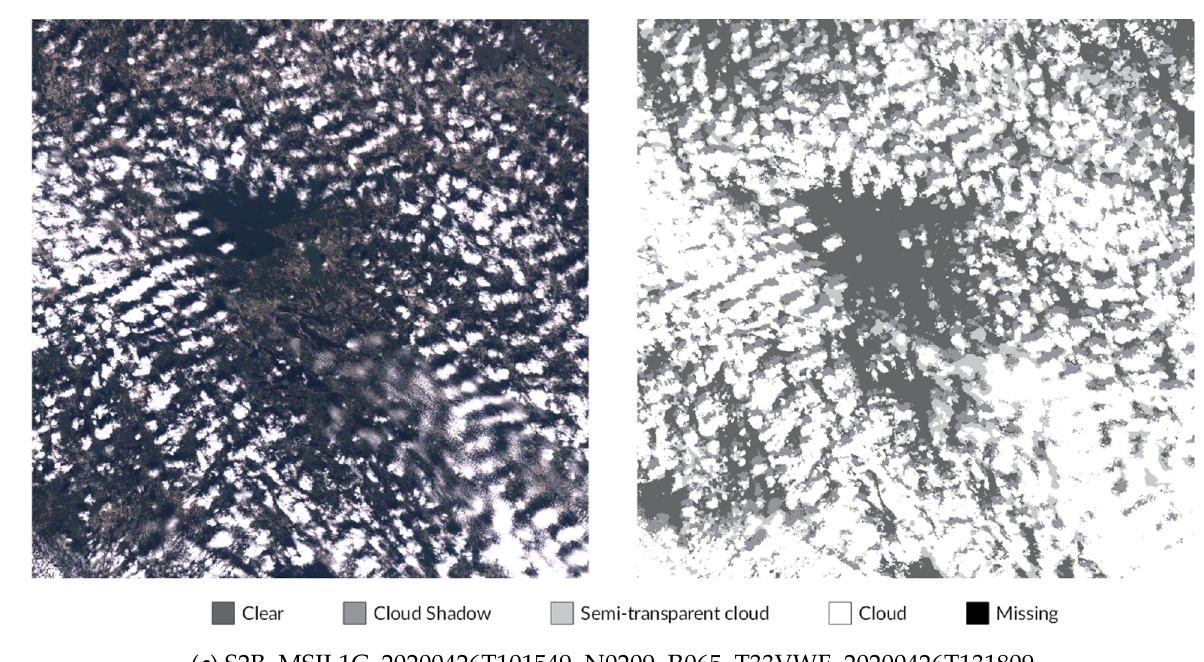
Figure A2. The whole Sentinel-2 L1C product (left) and its classification map (right) at 10 m resolution.